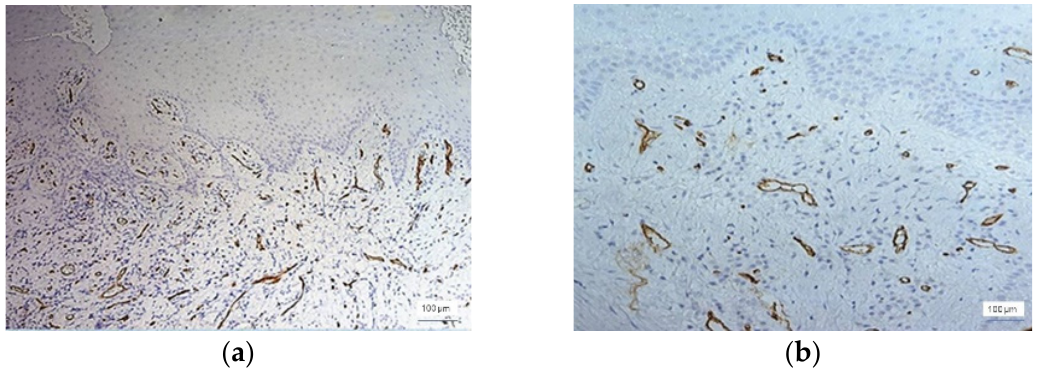
Figure 6. Moderate inflammation, GI = 2, and increased microvessel density at the stromal level, ×100: ( a ) stromal vascular polymorphism and intussusception, ×200, and ( b ) anti-CD34 immunohistochemical staining and DAB chromogen.